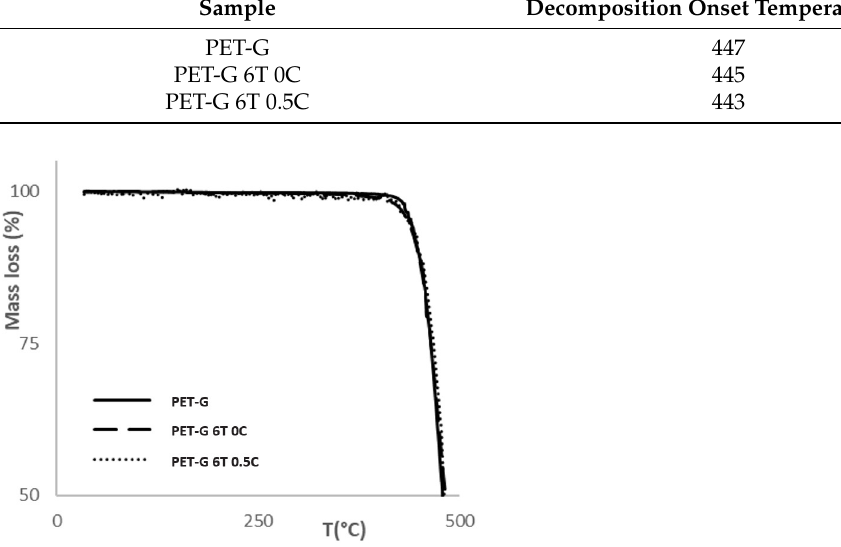
Figure 7. Test samples in order as in Table 6 after tensile testing .